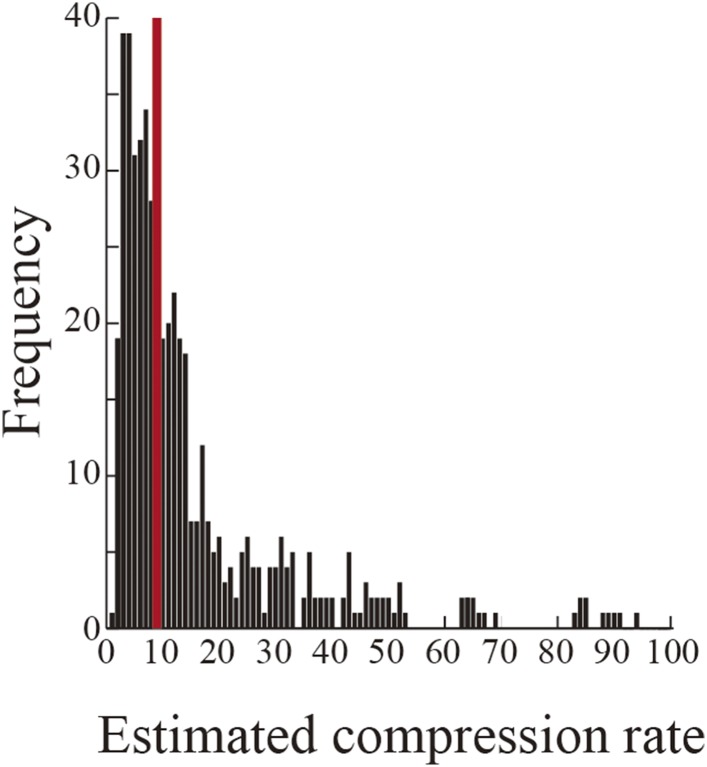
Estimated compression rate of firing during replays.Histogram of the compression rate of firing during replays, estimated across all rats as the average interspike interval during candidate replays divided by that during the entire session excluding the candidate replays. The red line indicates the median (9.0).